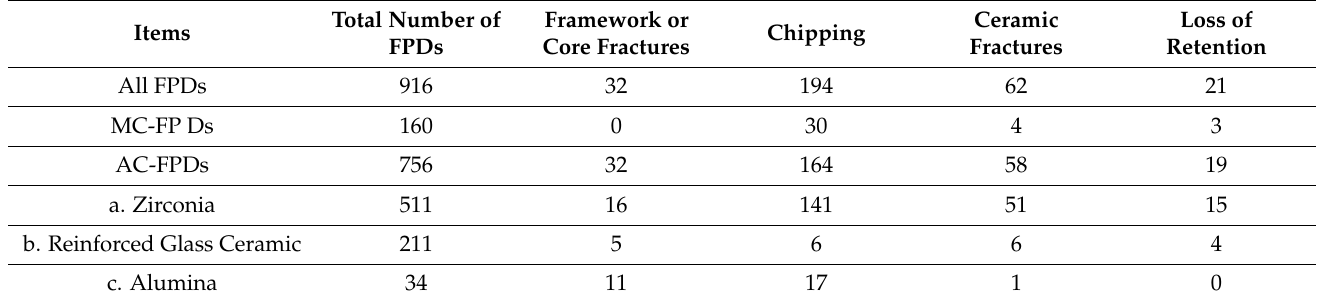
Table 4. Technical complications of metal-ceramic and all-ceramic fixed partial